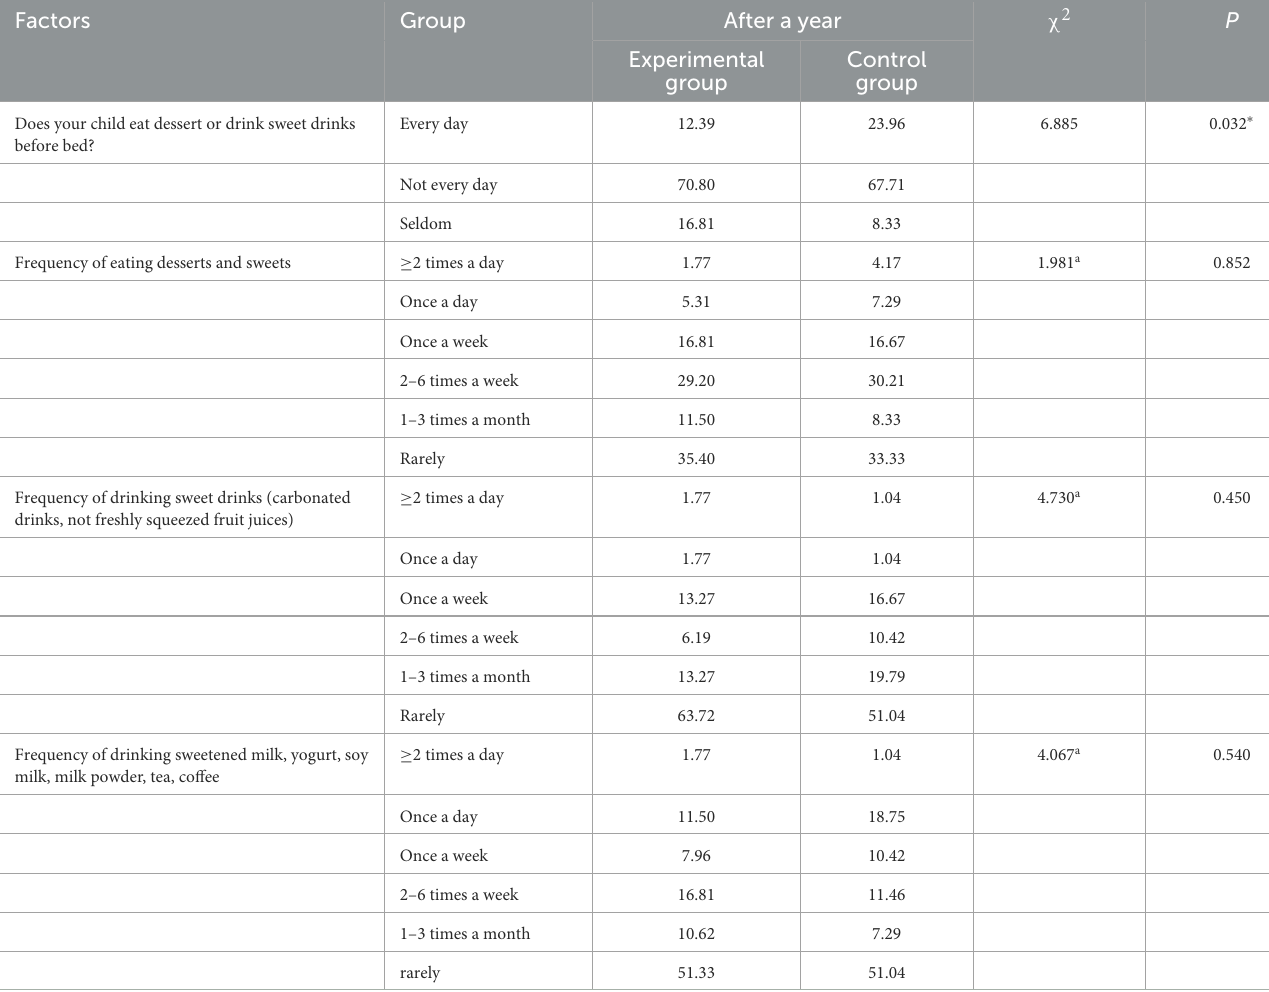
TABLE 3 Sugar consumption behavior of the two groups after a year (%). Factors Group